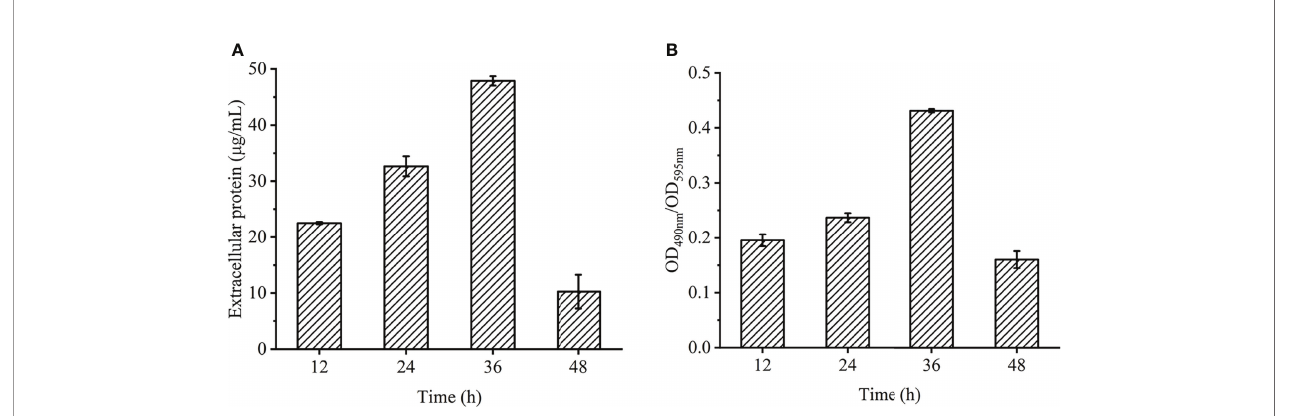
FIGURE 6 | Chemical composition and contents of EPS in V. parahaemolyticus bio fi lm at different times. (A) extracellular protein. (B) extracellular